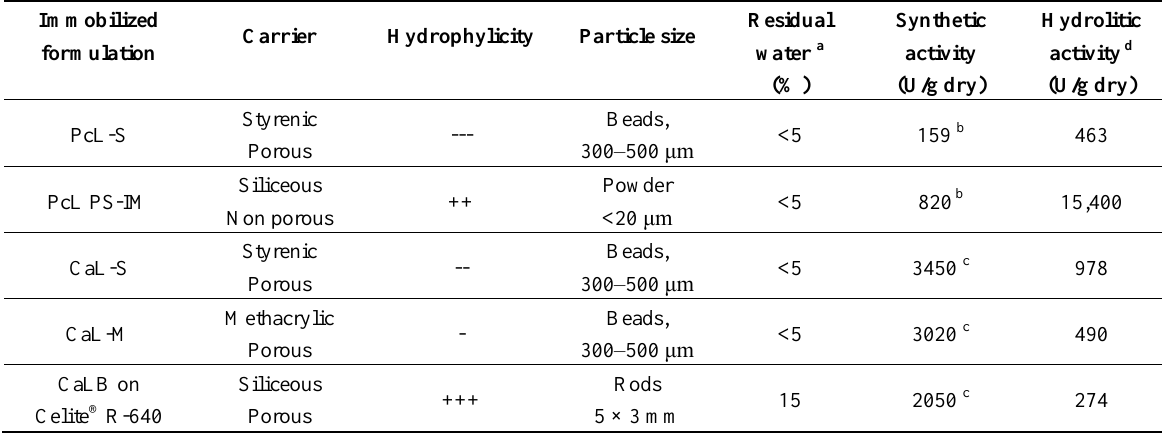
Table 1. Activity of immobilized lipases tested in the study. CaL = lipase B from Candida antarctica . PcL = lipase from Pseudomonas